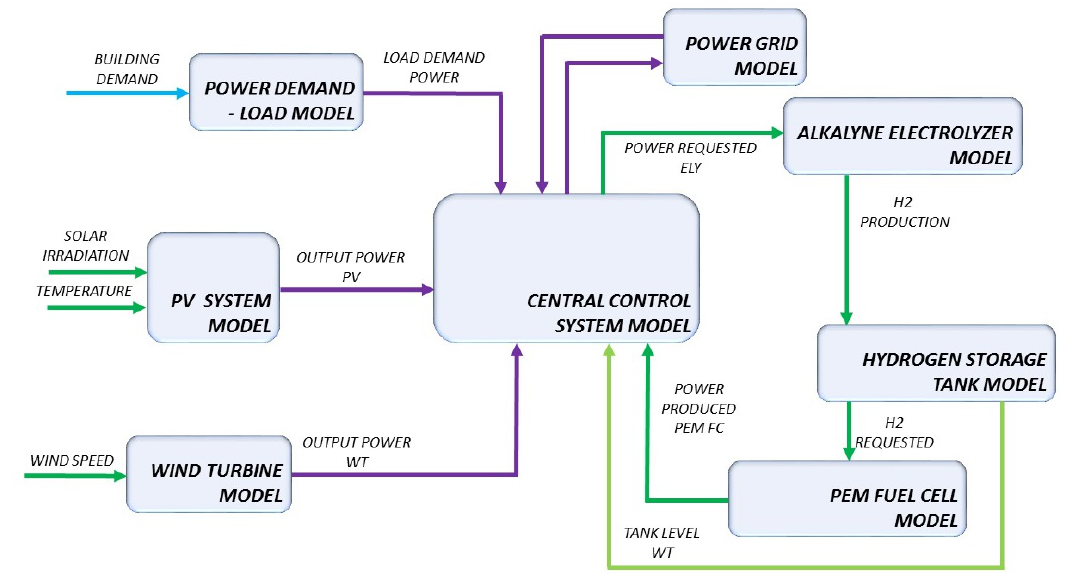
Figure 9. Global model. Integration of single models to central control system.